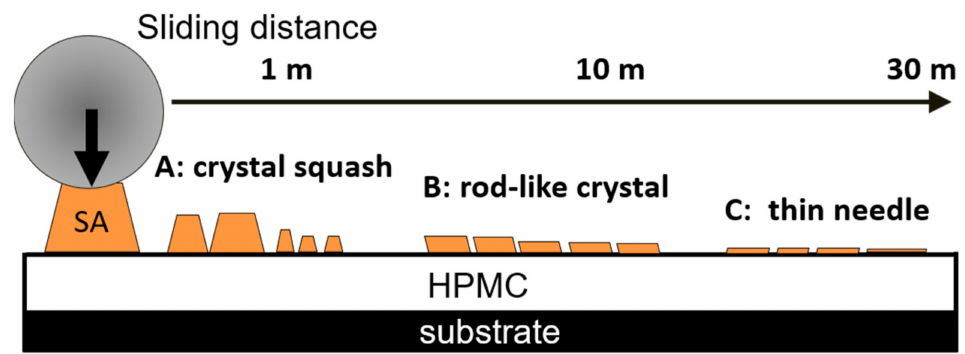
Figure 9. Schematic diagram of wear